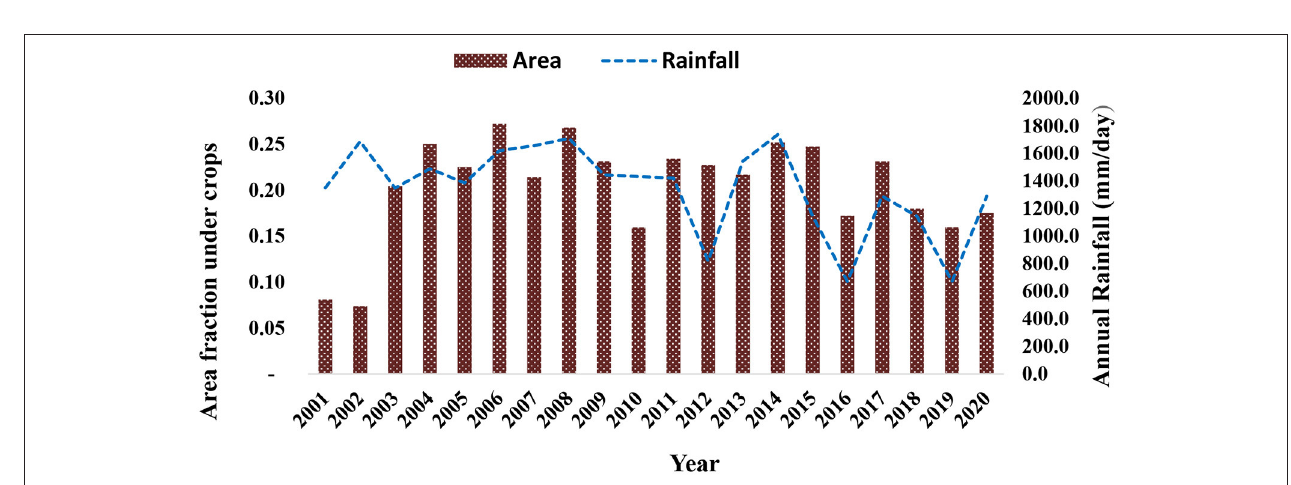
FIGURE 5 | The total number of households growing the indicated crops over the years (2001–2020).